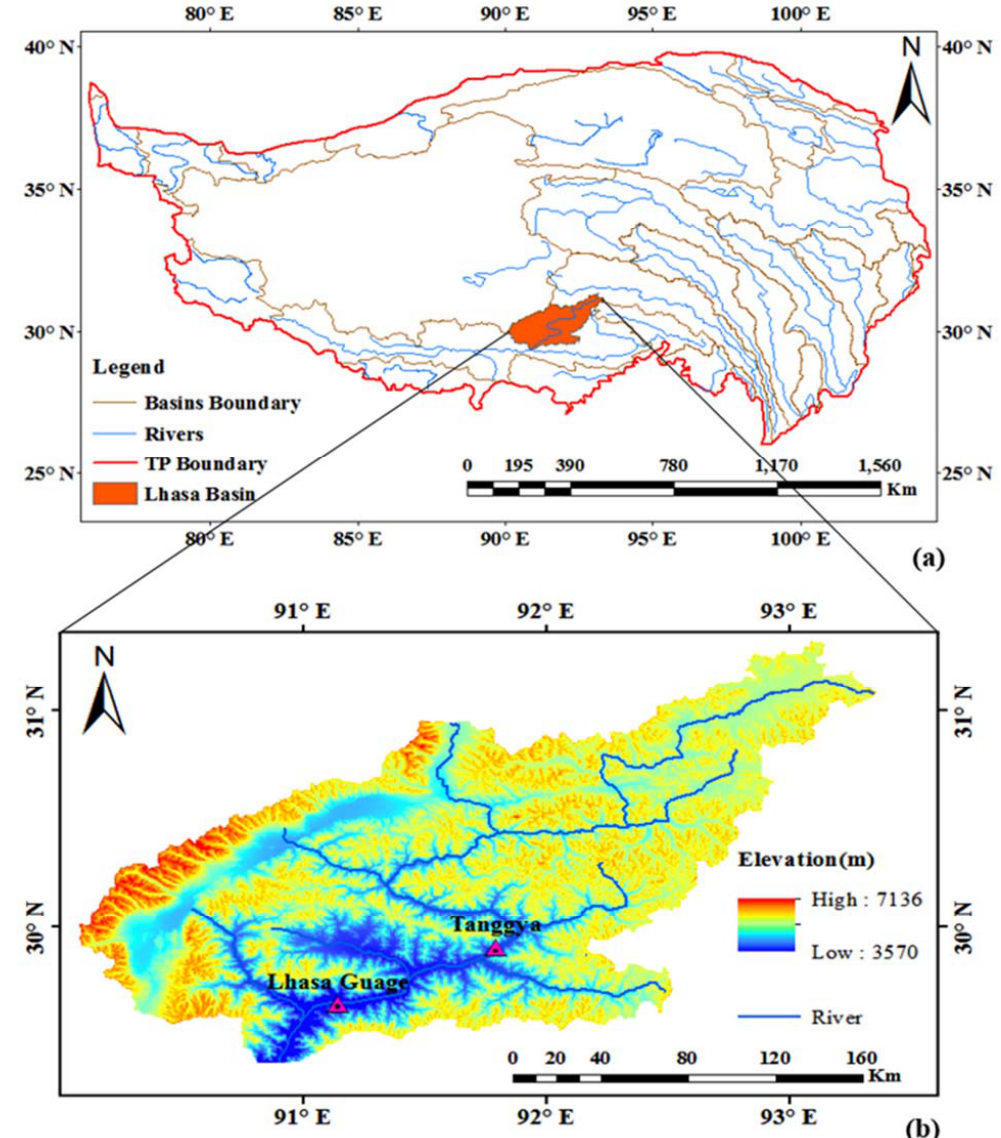
Figure 1. ( a ) Study area location in the Tibetan Plateau region; ( b ) the elevation of the Lhasa River basin (LRB) from the shuttle radar topography mission digital elevation model (SRTM DEM) with its hydrological